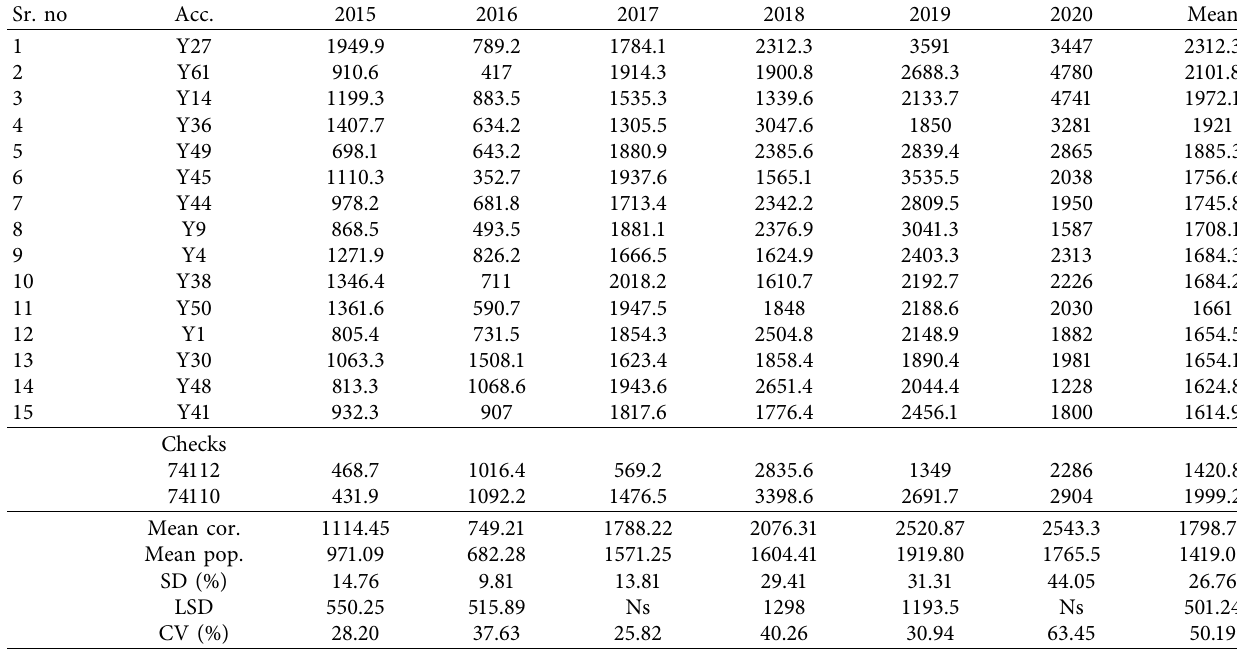
Table 8: List of 15 top high yielder accessions of set-I.